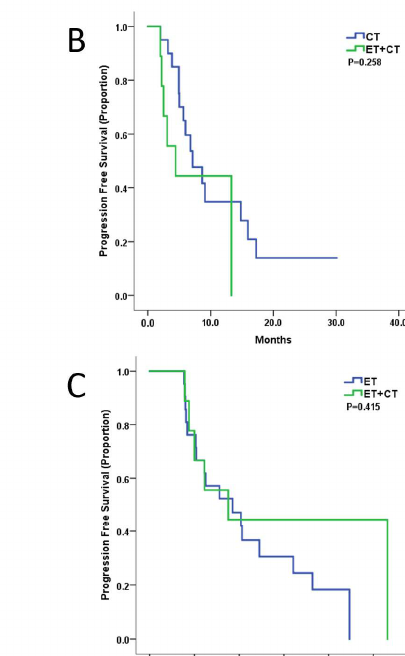
Figure 4. Analysis examples: A 53 year old female had both FES positive and negative lesions in the bone and received capecitabine treatment with a PFS of 15 months. 3.4. Safety We collected and analyzed the grade 3/4 adverse events of different treatment groups (Table 2). Only one diarrhea and leukopenia case were seen in the ET group, while more hematologic toxicity and peripheral neurotoxicity were observed in the CT group. Palmar- plantar erythrodysesthesia syndrome was seen in both the CT and ET + CT groups. Over- all, the three groups all showed an acceptable safety profile without a significant statistical difference ( p = 0.14). Table 2. Adverse events (grade 3/4). Adverse Events (Grade 3/4)